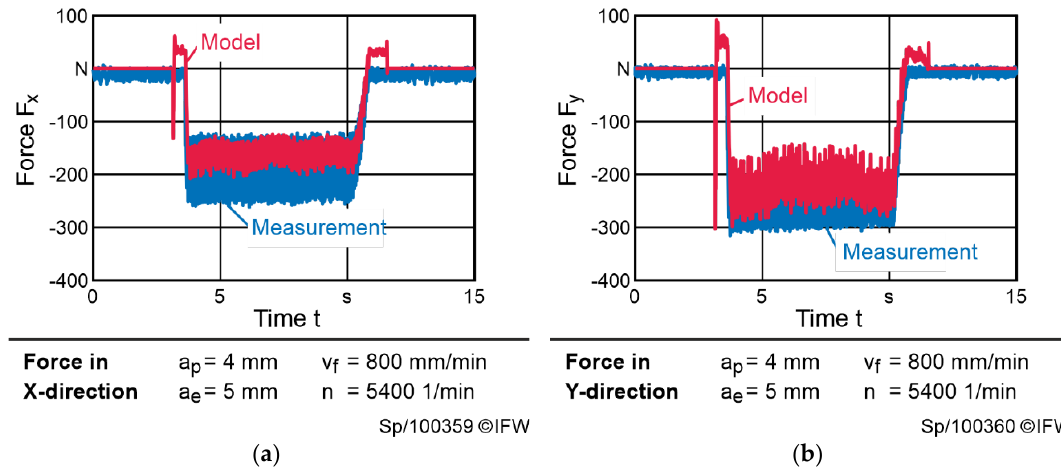
Figure 5. Comparison between measured process forces and the model-based approach during milling of a diagonal groove: ( a ) force acting in X -direction (RMSE = 30.74 N); ( b ) force acting in Y -direction (RMSE = 33.49 N).